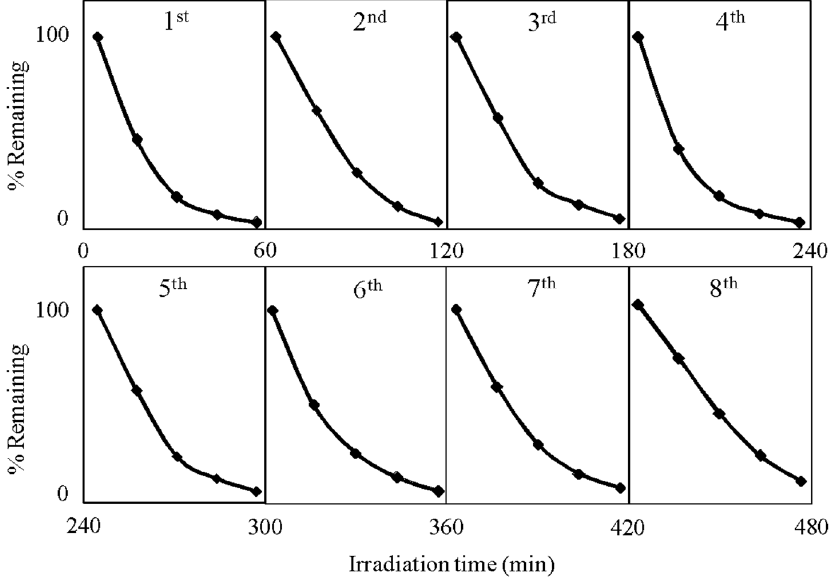
Figure 9. The recyclability graphs of TP2 under the photodegradation of MB dye.